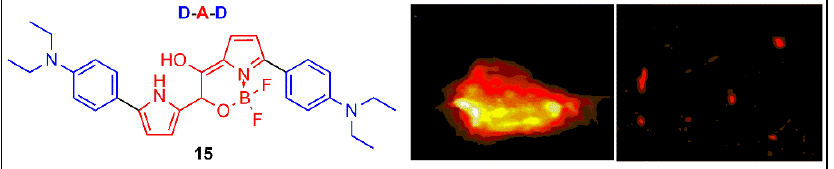
Figure 15. Fluorescence image of the AD model mice (left panel) and in vitro fluorescence staining of 15 on age-matched Tg mouse (right panel) — APP/PS1 transgenic, male. Adapted with permission from [77]. Copyright (2022) Elsevier.